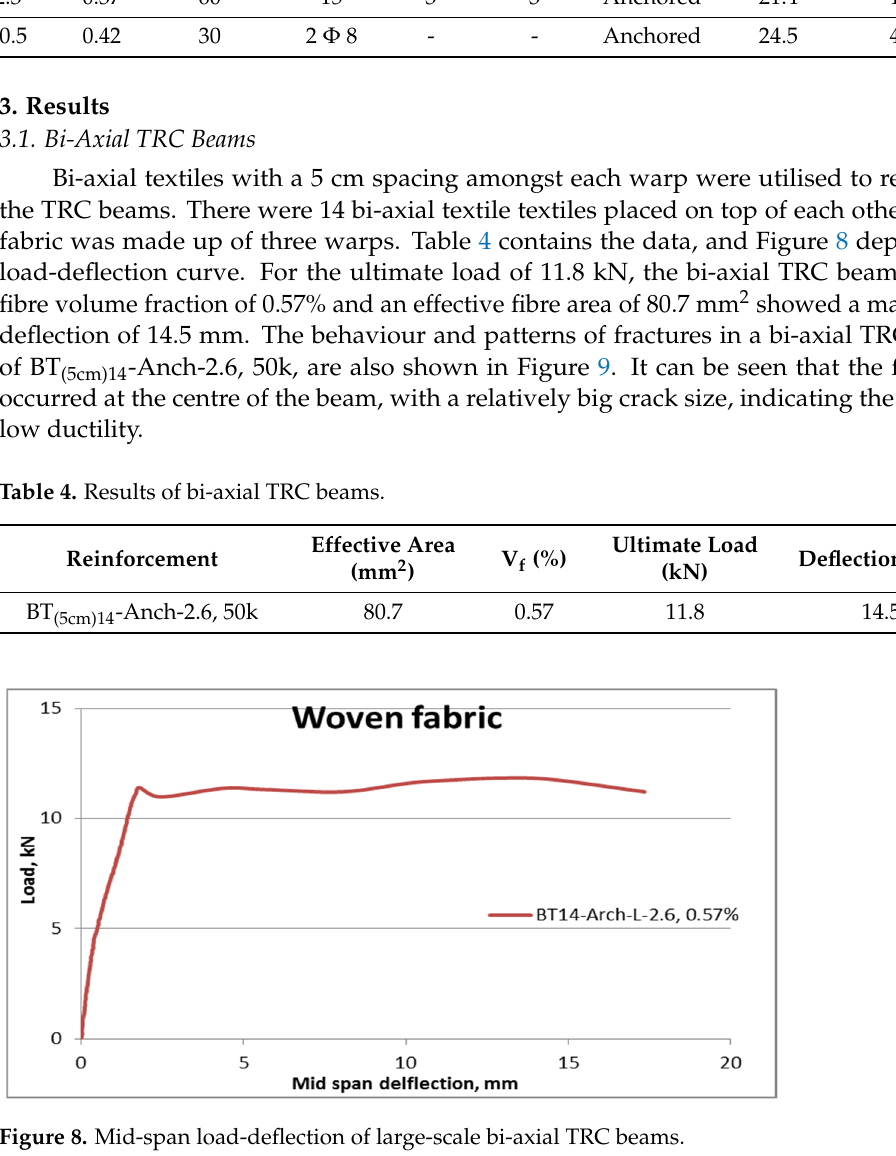
Figure 9. The failure mode and cracks pattern of BT (5cm)14 -Anch-2.6-L, 50k TRC beam. 3.2. Uni-Axial TRC Beams The uni-axial TRC beams with tow reinforcements were tested. The findings are di- vided into straight and anchored groups based on the reinforcement arrangement at the end of the beams. Based on the thickness of the cover, they are divided into three sub- groups. Table 5 displays the outcomes of uni-axial TRC beams with the straight end on both sides of the beams. Figure 10 depicts the load-deflection performance of uni-axial TRC beams with various configurations. It can be seen that the uni-axial TRC beam of